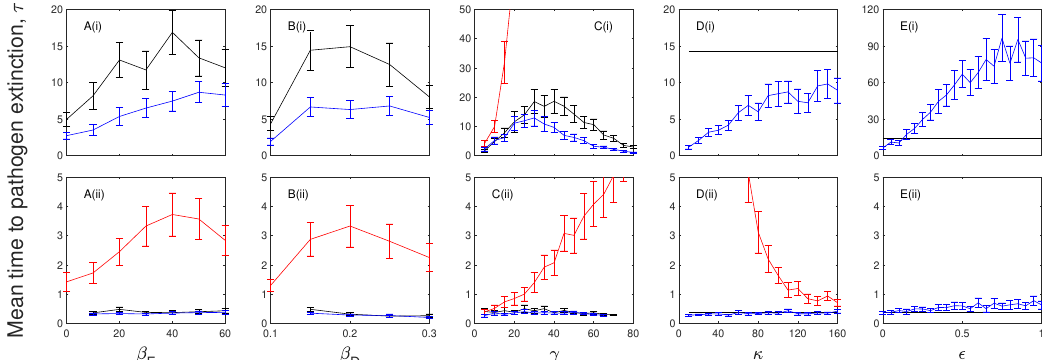
Figure 6. A parameter sensitivity analysis for the SIS (black) and SICS model frameworks with a chronically infected class that exhibits disease-induced mortality ( c = 0.5, (cid:101) = 0, blue) and a chronically infected class that can transmit the infection ( c = 0, (cid:101) = 0.5, red) for ( i ) α = 40 and ( ii ) α = 80. The mean time to pathogen extinction (with 95% confidence intervals) is plotted against ( A ) the frequency-dependent transmission rate, β F ; ( B ) the density-dependent transmission coefficient, β D ; ( C ) the infected recovery rate, γ ; ( D ) the chronically infected progression rate, κ ; and ( E ) the chronically infected infectiousness, (cid:101) . When not changed in the figure baseline parameter values were used (see Table 2). Note, at low levels of disease-induced mortality, α = 10, the mean time to pathogen extinction exceeds our simulation time scale and so results are not shown. Red lines are not shown in figure ( A(i) ), ( B(i) ), and ( D(i) ) as here τ exceeds our simulation time scale. Red lines are not shown in ( E(i) ) and ( E(ii) ) as this scenario assumes chronic individuals are